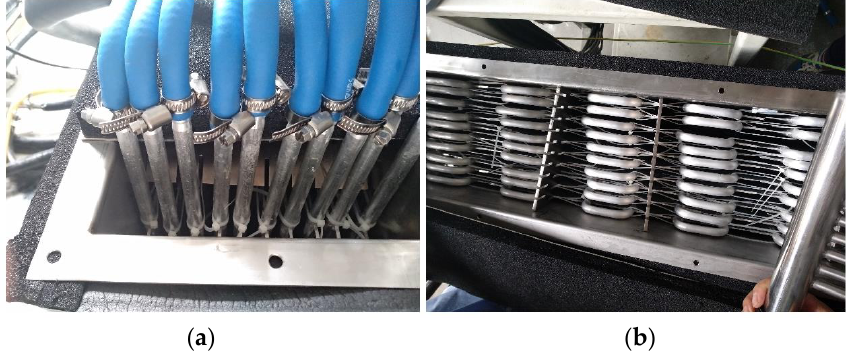
Figure 2. Photographs of the ice storage container ( a ) and coil-plate heat exchanger ( b